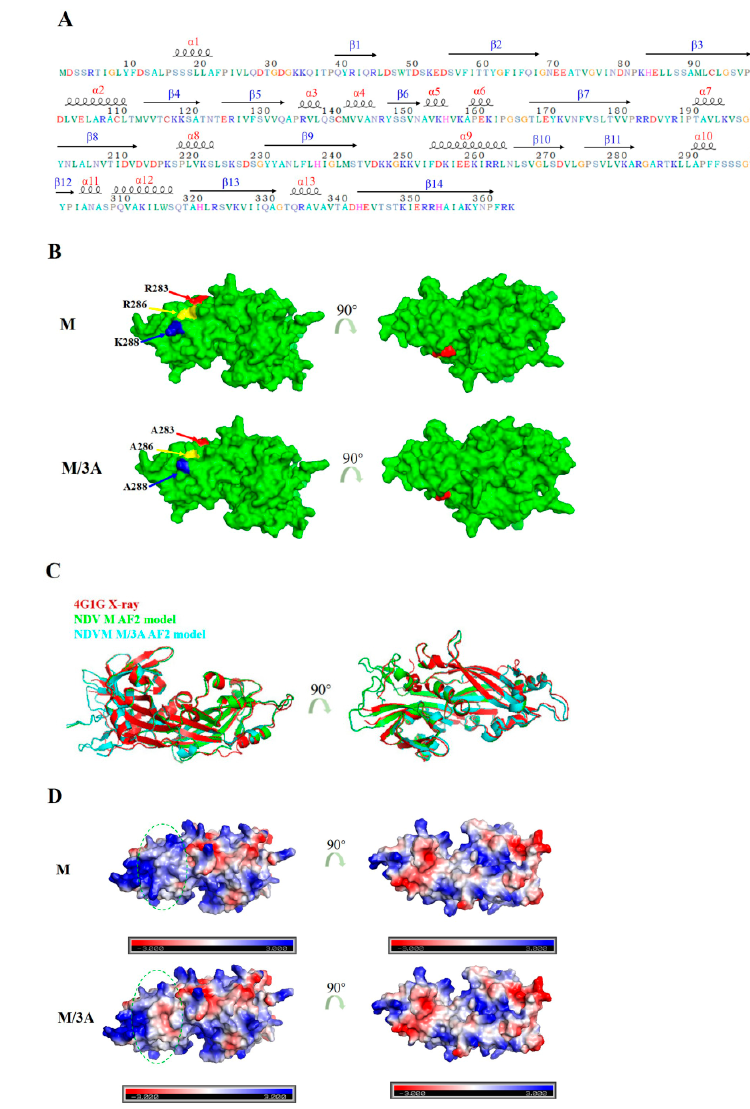
Figure 2. The M/3A protein has a changed electrostatic pattern. ( A ) Analysis of the secondary structure composition in the NDV M protein. ( B ) The 3D monomeric structural model of the M and M/3A proteins generated by AlphaFold2 (AF2) and PyMOL 2.5.4. Red, yellow, and blue represent the amino acids R283, R286, and K288, or A283, A286, and A288. ( C ) The cartoon drawing of the monomeric structure of M and M/3A proteins generated by PyMoL 2.5.4. ( D ) The electrostatic representations of the 3D monomeric structural model of the M and M/3A proteins generated by the APBS Electrostatics module of PyMoL 2.5.4. Blue indicates positively charged regions; red indicates negatively charged